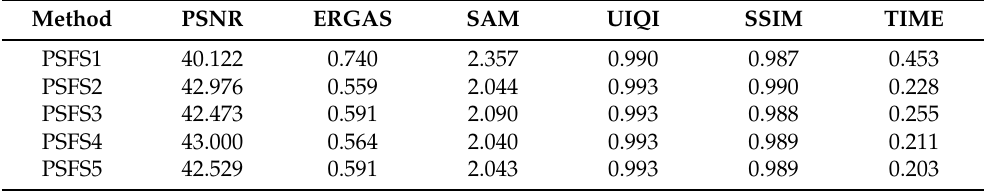
Table 7. The results of the different PSF set in FTMSVD on the Pavia University data set.